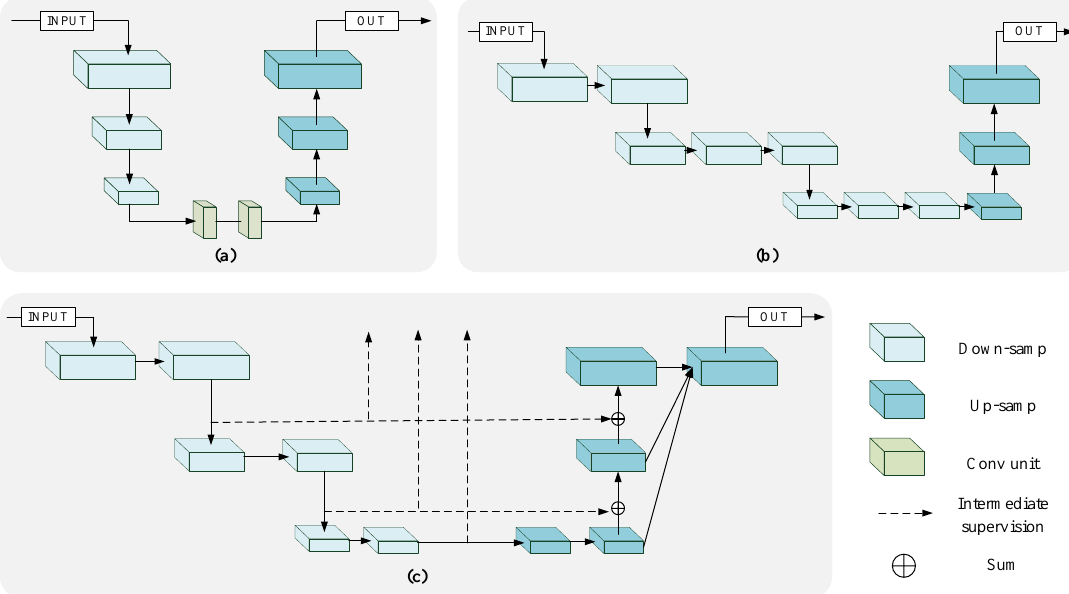
Figure 1. Illustration of representative networks that rely on the high-to-low and low-to-high series framework. ( a ) U-shaped mirror symmetric framework. Hourglass [26] and its variants [25]. ( b ) Asymmetrical framework with heavy high-to-low and light low-to-high. The high-to-low process is based on a large backbone, and the low-to-high process is light [24]. ( c ) High-to-low and low-to-high framework with intermediate supervision [24] or fusion strategy